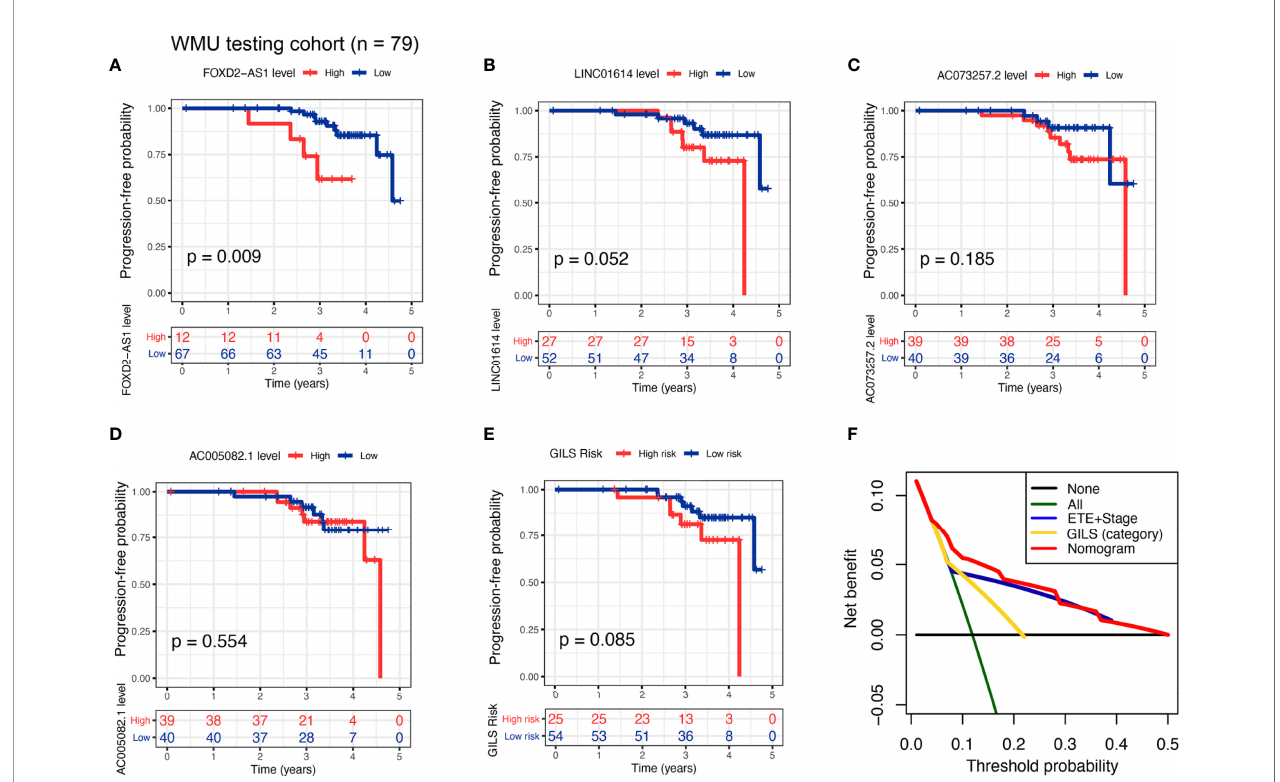
FIGURE 6 | External test of the GILS using WMU-PTC cohort. Kaplan – Meier curves comparing patients with high- and low-level of (A) FOXD2 − AS1 , (B) LINC01614 , (C) AC073257.2 , and (D) AC005082.1 , as well as (E) high- and low- GILS score along with the log-rank test. The p -values and HR with con fi dence intervals are shown for PFS in the WMU-PTC testing cohort. (F) Analysis of the decision curve GILS was superior to other models. PFS, progression-free